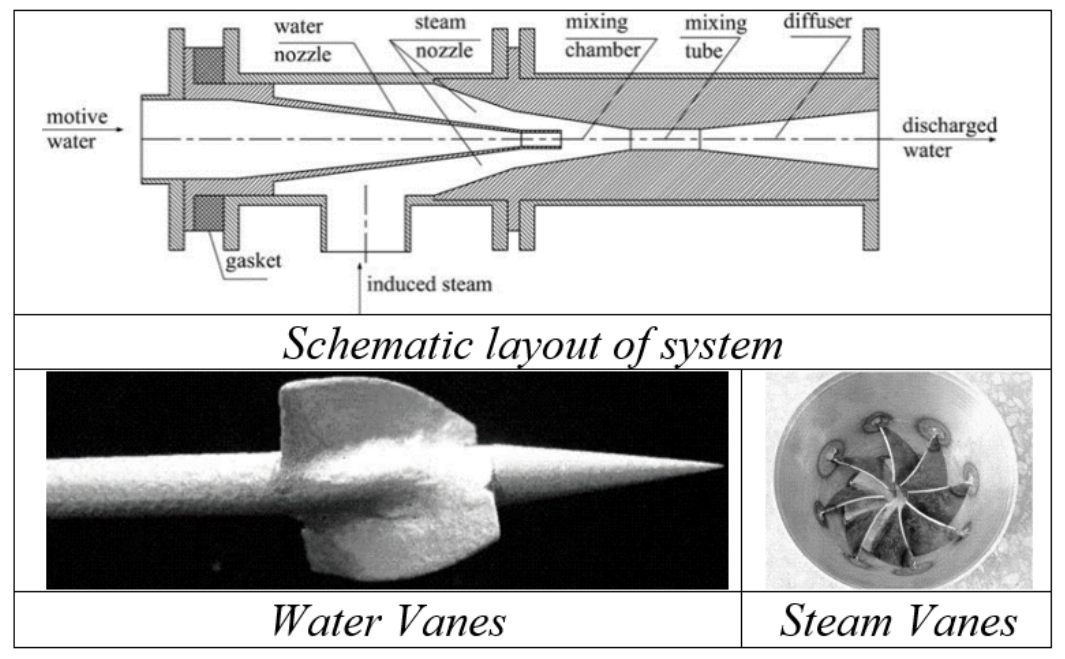
Figure 14. Schematic test setup with swirling vanes for water and stem nozzle [68].